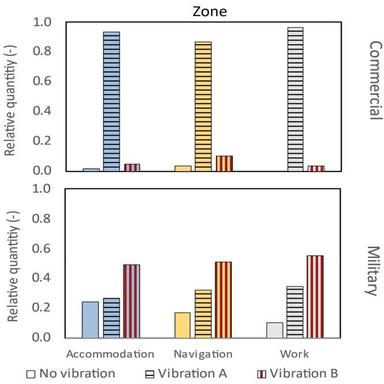
Vibrations induced by LF noise are classified by zone and ship typology.